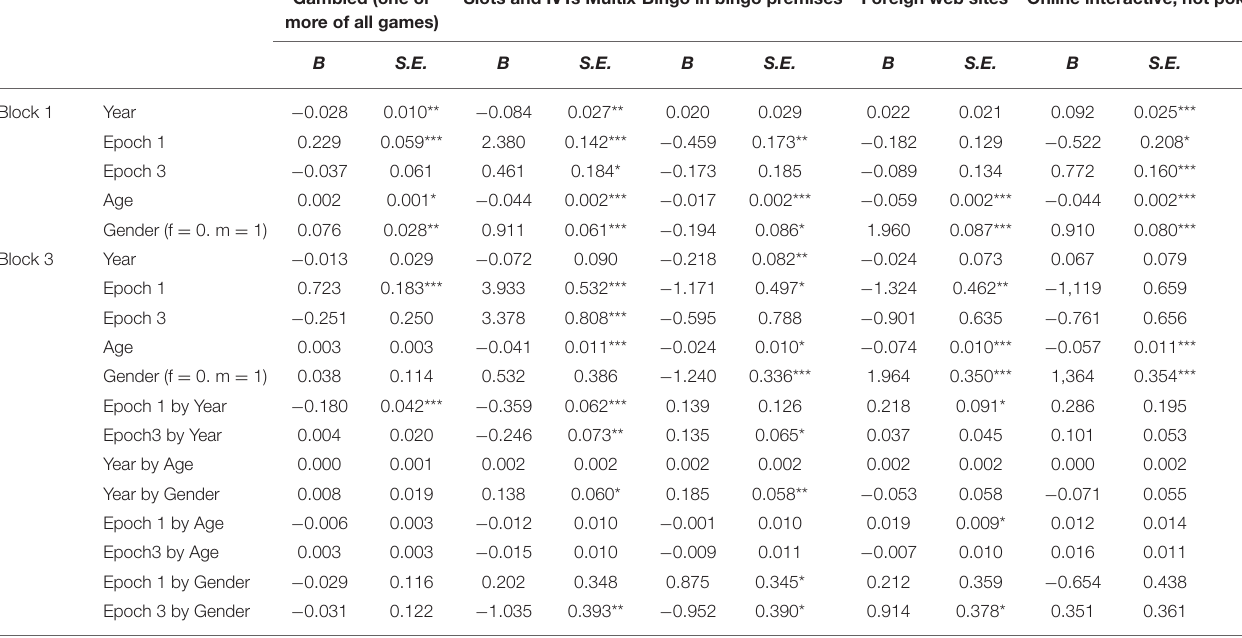
TABLE 4 | Logistic regression analyses of five gambling variables in the Norwegian gambling market year